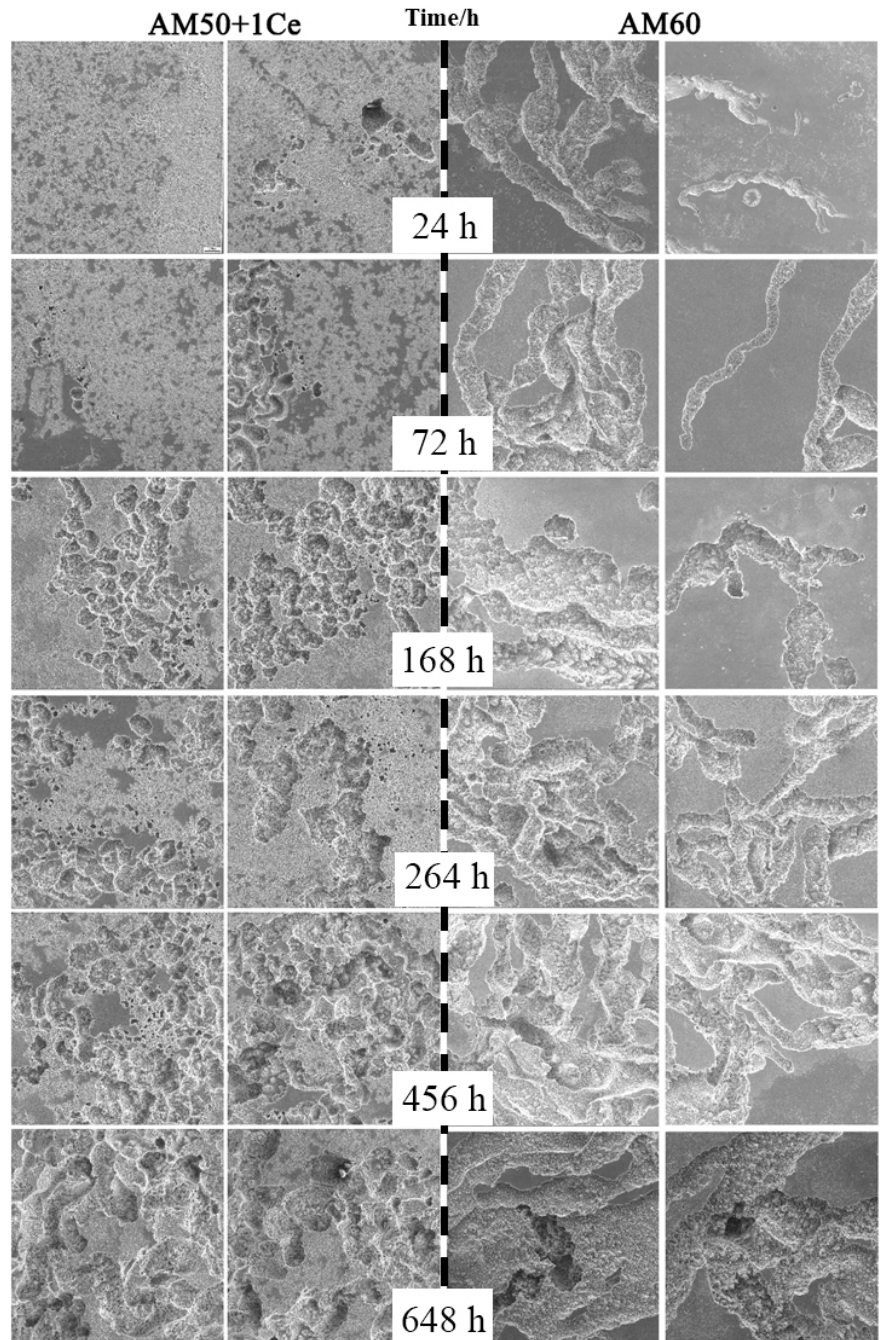
Figure 14. The corrosion morphology of HPDC AM50 + 1Ce and AM60 in 3.5 wt% NaCl solution for immersion of 24 h, 72 h, 168 h, 264 h, 456 h and 648 h.